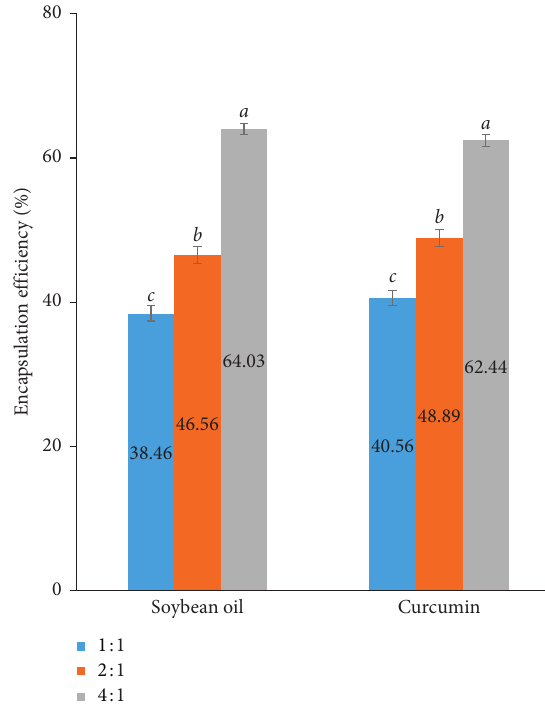
Figure 6: Encapsulation efficiencies of soybean oil and curcumin in microcapsules with different shell:core